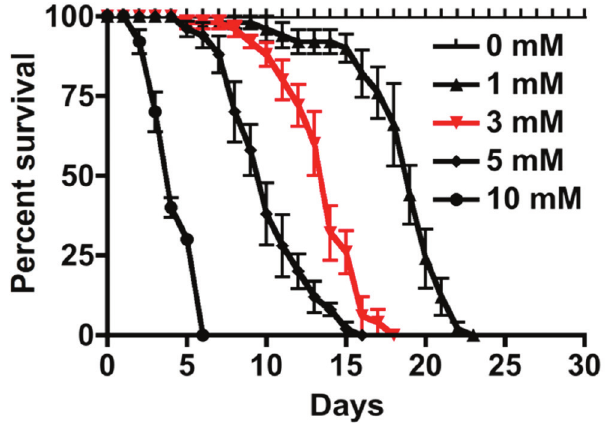
various dosages of BMAA. Five day-old male flies were reared in 1, 3, 5, and 10 mM BMAA diluted in 3% sucrose for up to 30 days (10 flies per vial). The 50% survival time for 1, 3, 5, and 10 mM BMAA was 19, 14, 10, and 4 days, respectively. The sham (0 mM BMAA) treated flies did not show any toxicity during the observation period. The statistics was performed using One-way ANOVA analysis of variance in Prizm software, p<0.01 (n=50 for 1, 3, and 5 mM BMAA groups; n=20 for the 0 mM BMAA group). Survival curve of wild type (Canton S) Drosophila under